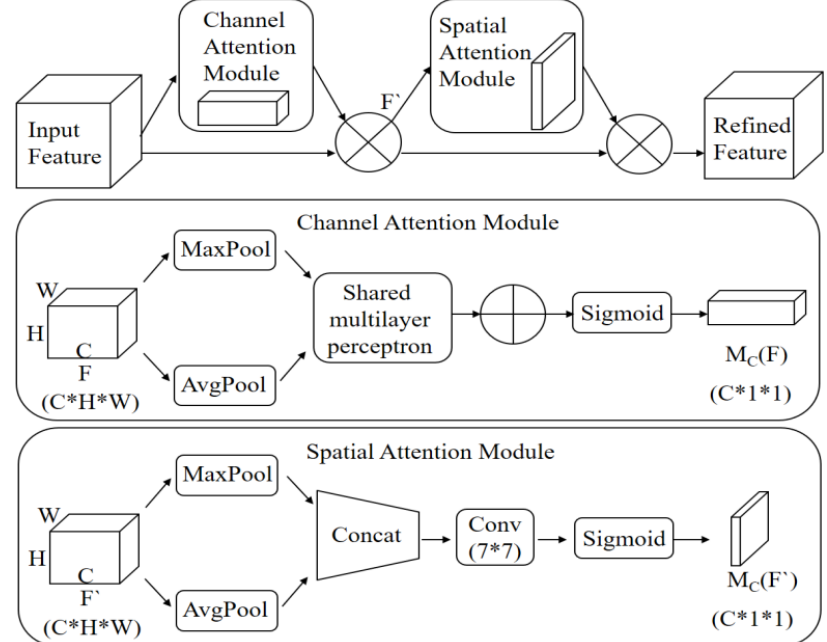
Figure 9. Structure of CBAM module.